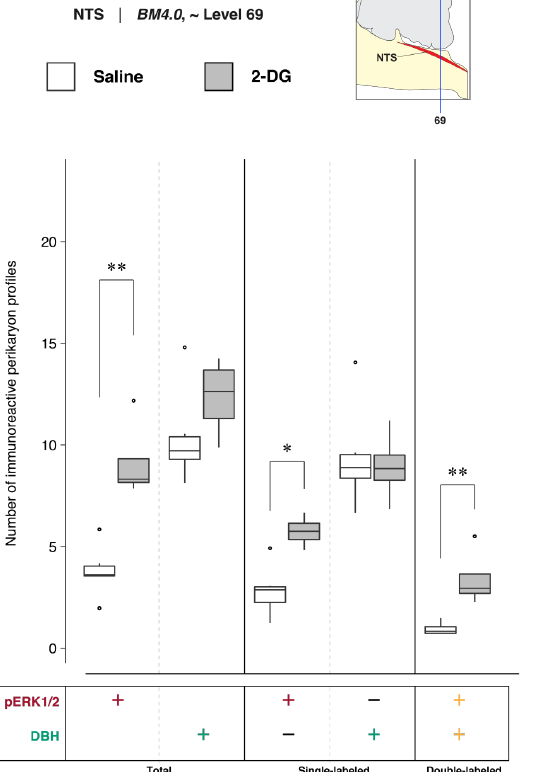
Figure 10. 2-DG administration is associated with a marked alteration of activation patterns in nu- cleus of solitary tract (>1840) (NTS) perikaryon profiles anatomically registered to BM4.0 atlas level 69. Abercrombie-corrected [106] perikaryon profile counts from both saline- and 2-DG-treated sub- jects are represented as box plots displaying the total numbers of phospho-ERK1/2- or DBH-immu- noreactive profiles, or only the single- and double-labeled profiles, from tissue sections identified to be in register with BM4.0 atlas level 69 (map, upper right ). An asterisk (*) denotes statistical signifi- cance between groups with an FDR-adjusted p < 0.05; a double asterisk (**) denotes an FDR-adjusted p < 0.01. See Tables S5 and S6 for details. On the box plots, potential outliers are presented as open circles.